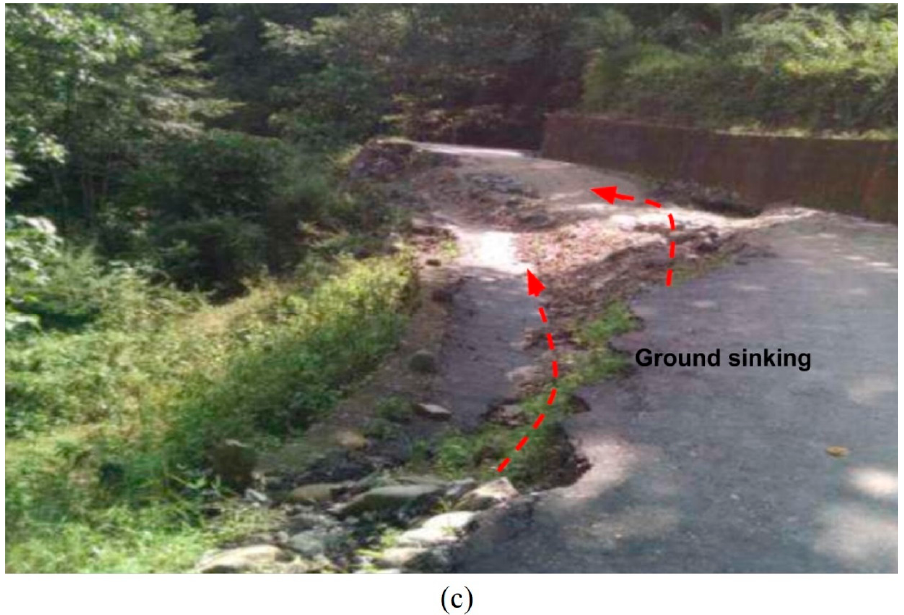
Figure 9. Displacements observed at Chibo after 2017 monsoon: ( a ) depression, ( b ) crack observed in ground, ( c ) ground sinking [22].